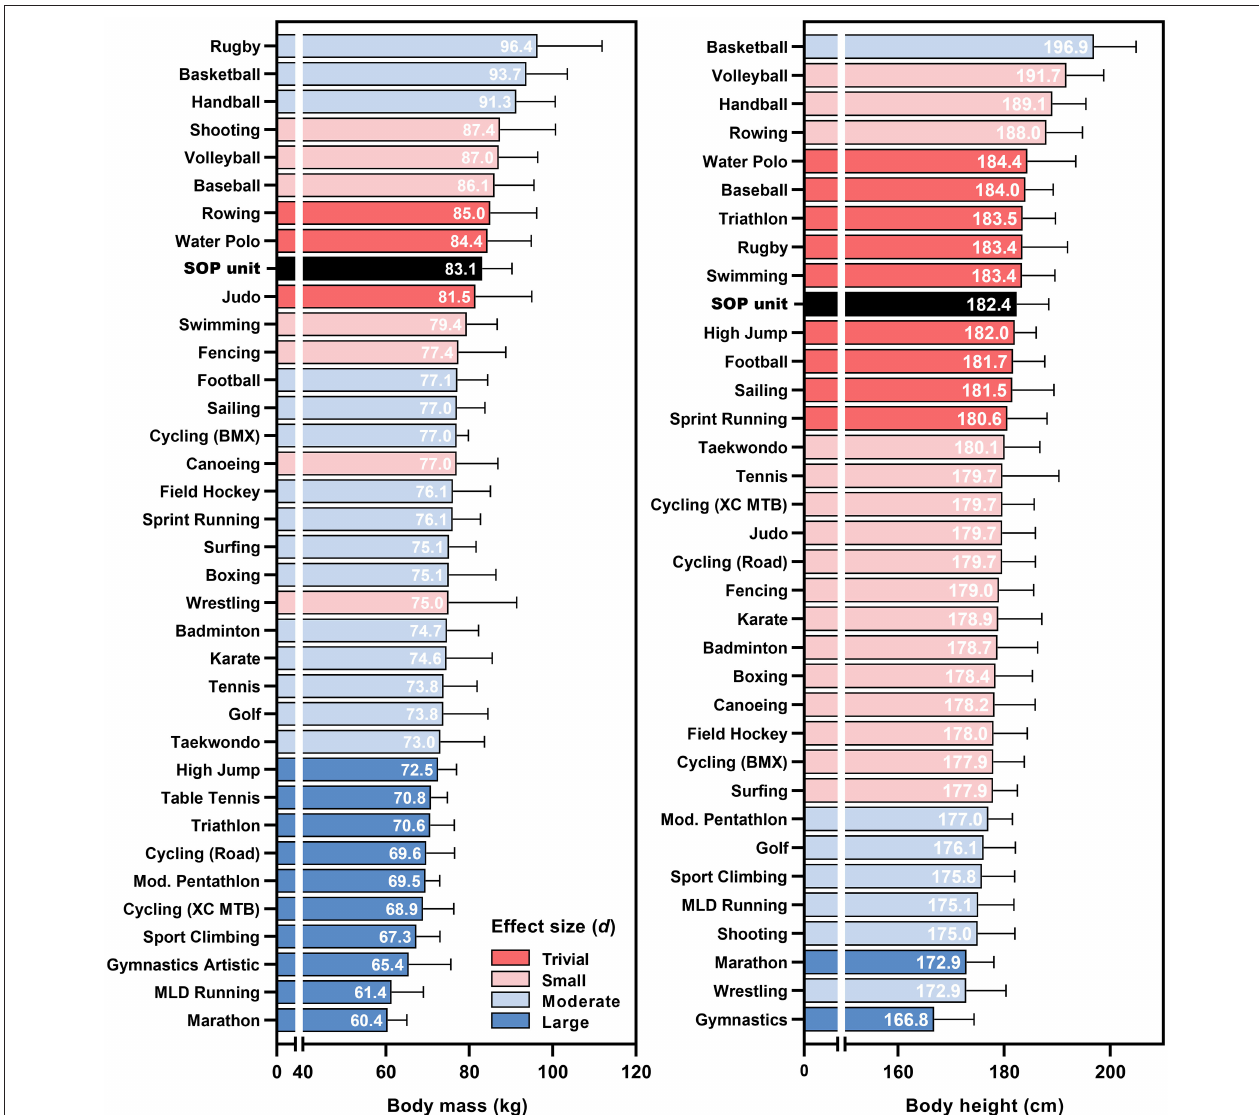
FIGURE 2 | Average body mass and height of elite athletes from Summer Olympic disciplines and the Special Operations Police unit (SOP unit), sorted by size. The color scale illustrates the effect size of each discipline compared to the SOP unit. BMX, Bicycle motocross; MLD, Middle- and long distance; XC MTB, Cross-country mountain